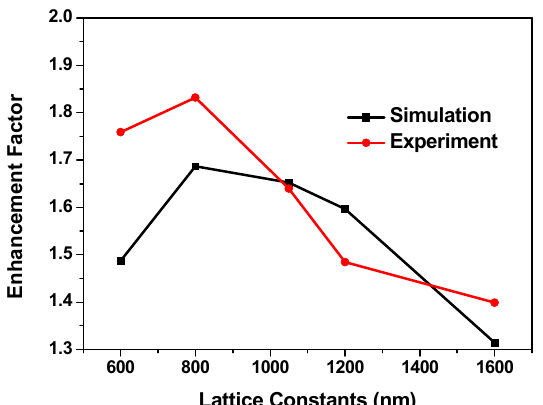
Figure 3. Dependence of the experimental and calculated enhancement factors of light extraction on the lattice constant.